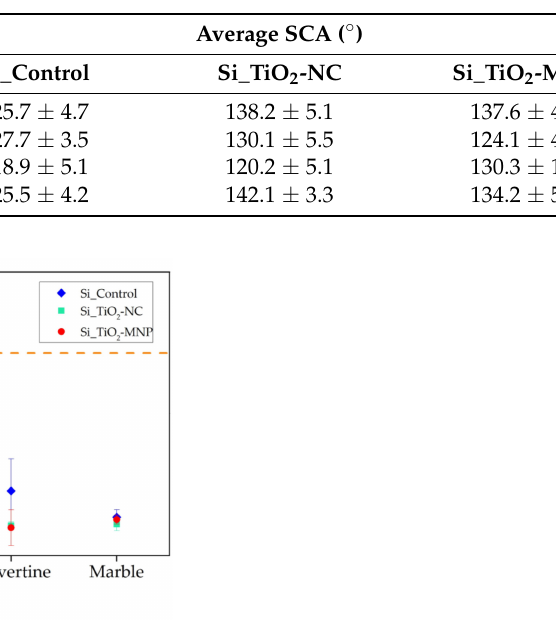
Table 3. SCA values for all treated stones.